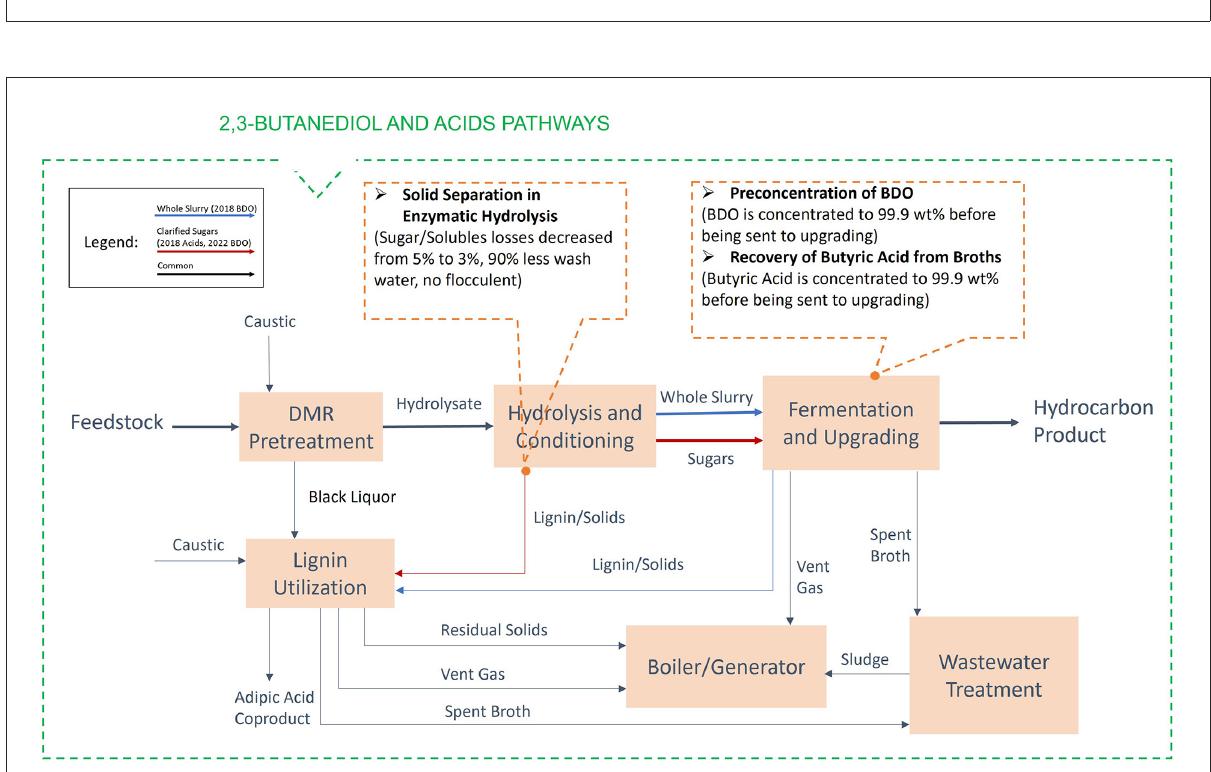
FIGURE4 Estimated cost and energy reductions for the HTL separation challenge stream assessments. The cost and CO 2 emission reduction for the trace water and trace solid removal from biocrude oil were combined.